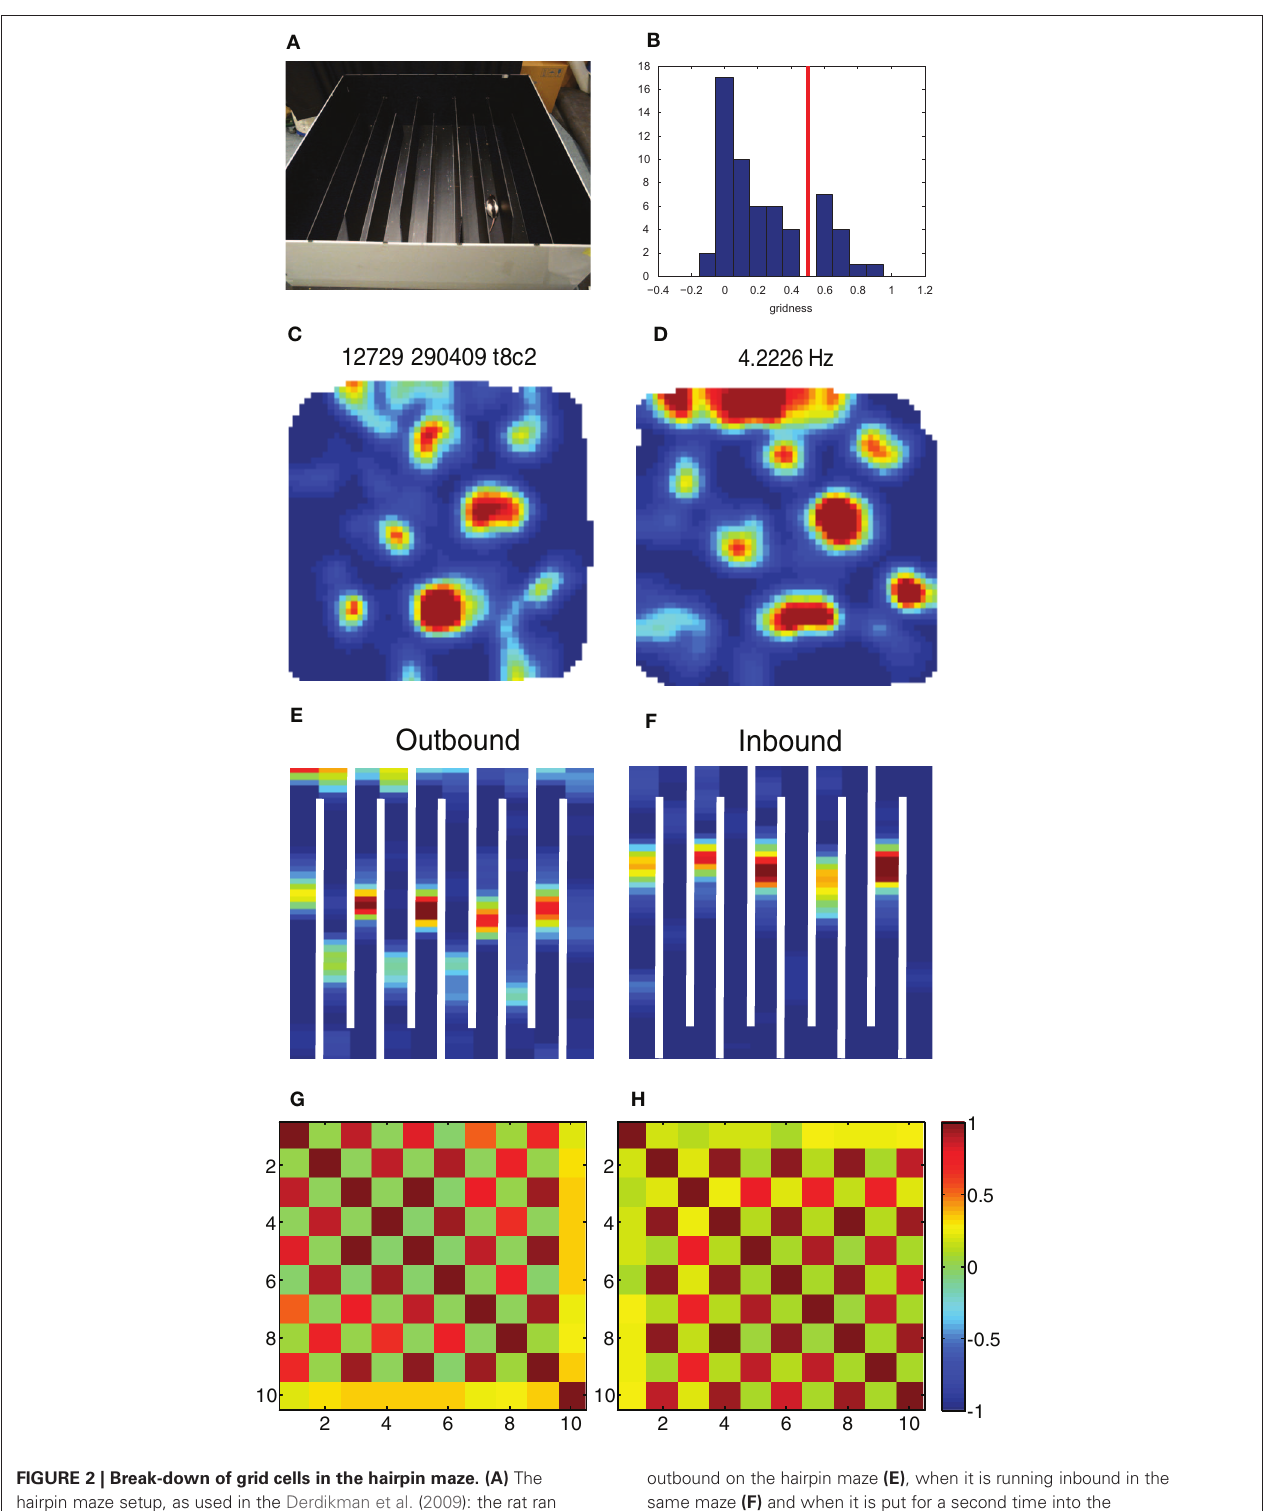
FIGURE 2 | Break-down of grid cells in the hairpin maze. (A) The hairpin maze setup, as used in the Derdikman et al. (2009): the rat ran first in the open-field, then in the hairpin maze, and then finally in the open-field again. (B) Grid score histogram (value averaged for first and second open-field sessions) for all 61 cells. Chosen threshold for conjunctive cells (0.5) is marked in red. (C–F) Example of a conjunctive cell when the rat is in the open-field (C) , when the rat is running